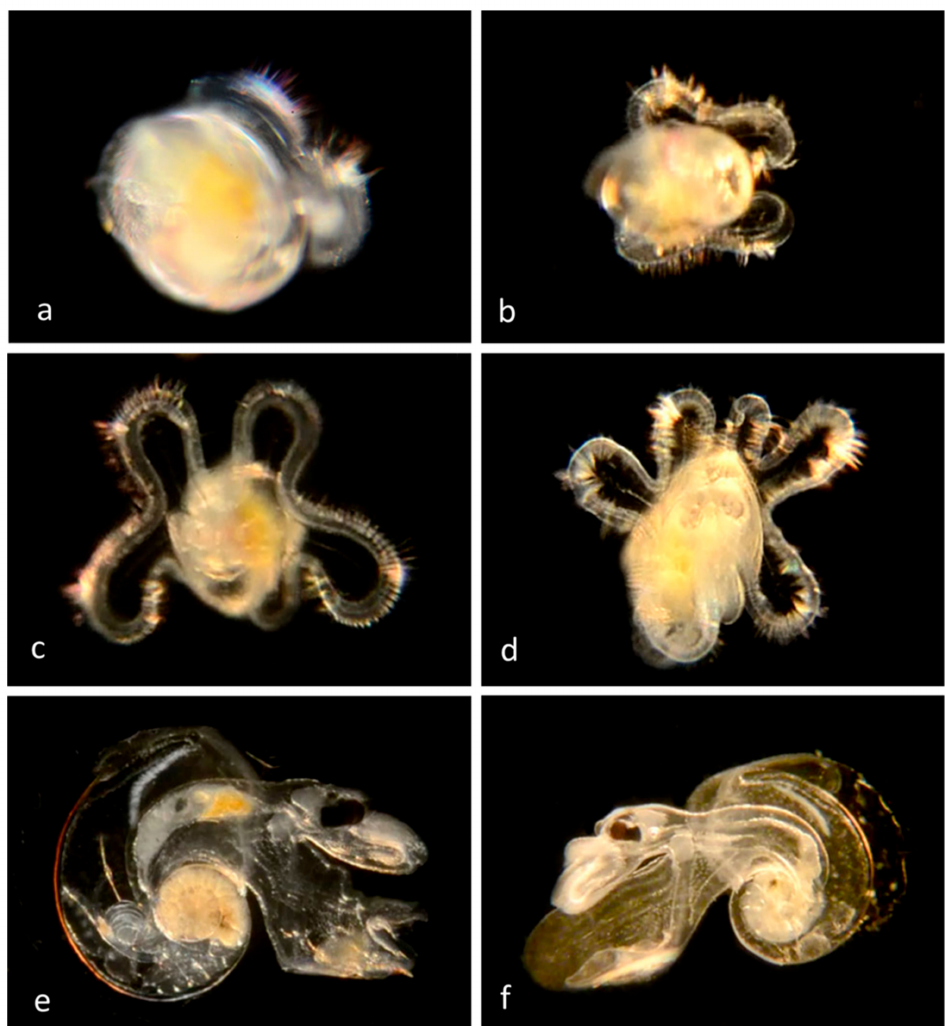
Figure 3. Family Atlantidae: Sea snail , Atlanta californiensis (BINACV0973; n = 19). ( a ) Early veliger BIOUG01205-B08 from off Dana Point. ( b ) Later veliger with bilobed velum CCDB-24236-G01 from off Newport Pier. ( c ) Veliger with bilobed velum CCDB 31597 E12 from Newport Harbor entrance. ( d ) Later veliger with 6-lobed velum CCDB-24236-H05 from Newport Harbor. ( e ) Adult CCDB 31597 E09 from Newport Harbor entrance. ( f ) Adult CCDB-24722-D06 from La Profunda, Baja